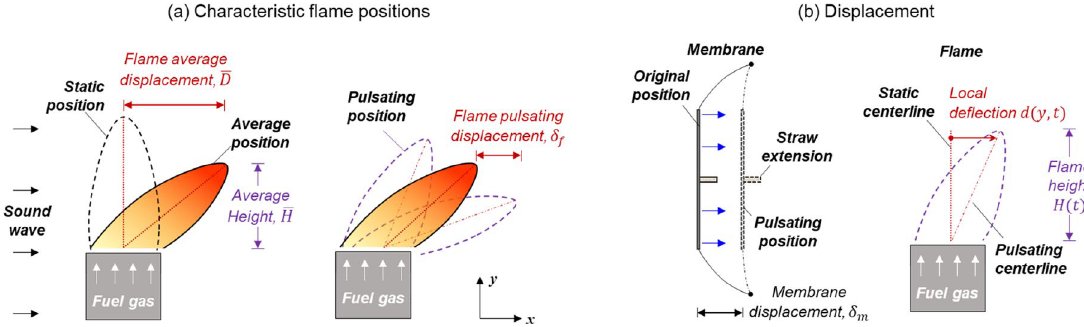
Figure 2. ( a ) The characteristic flame positions during fluctuation, and ( b ) displacements of speaker membrane (straw) and